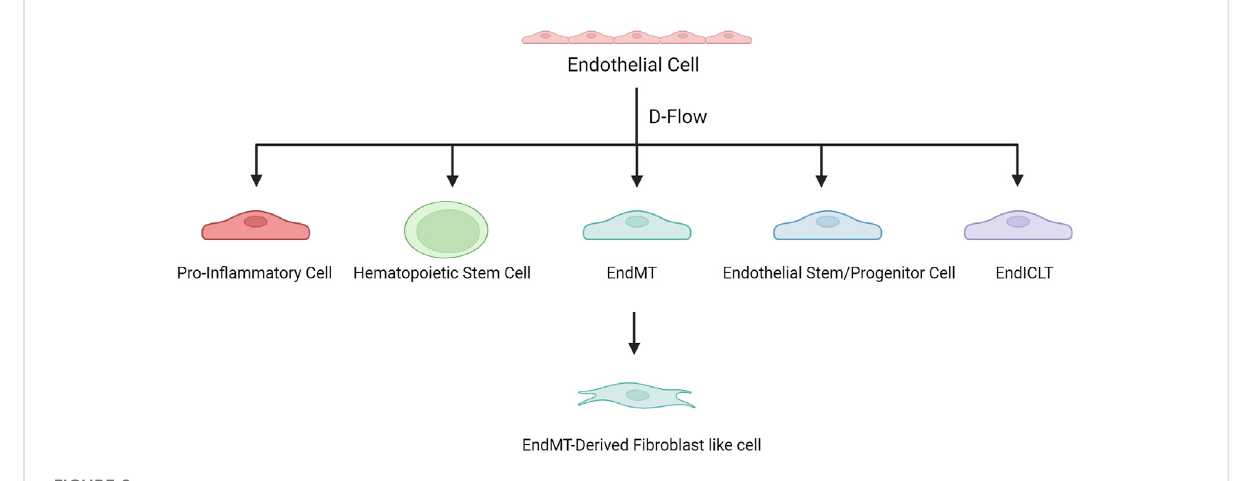
FIGURE 2 D- fl ow induces EC recoding to produce multiple proatherogenic